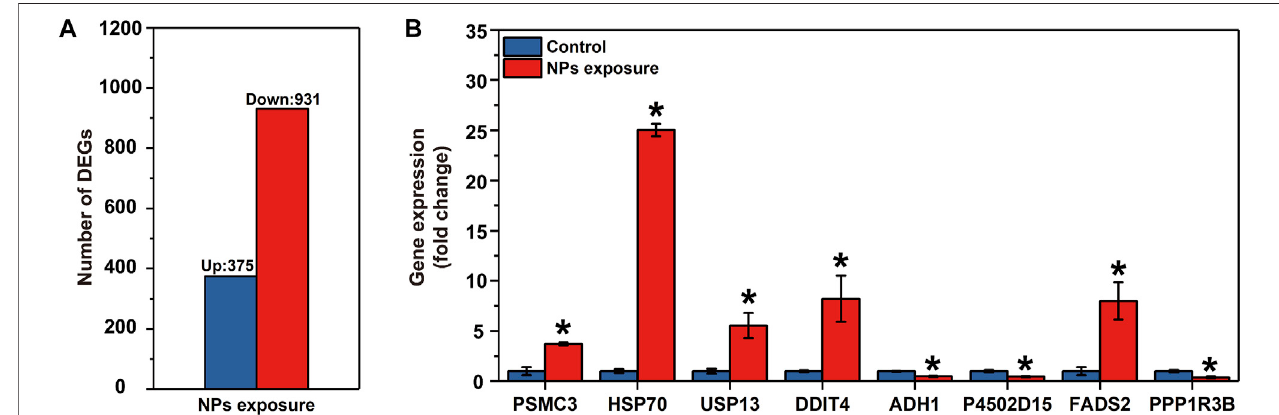
FIGURE 2 | Results of the RNA-seq in the larval Ietalurus punetaus after 48 h of exposure to 50 mg/L polystyrene nanoplastics. (A) number of differentially expressed genes. (B) validation of key differentially expressed genes via real-time PCR. Data are represented as mean ± standard error. Star symbol indicates a signi fi cant change in gene expression between the exposure and control groups and signi fi cant threshold is set as p <